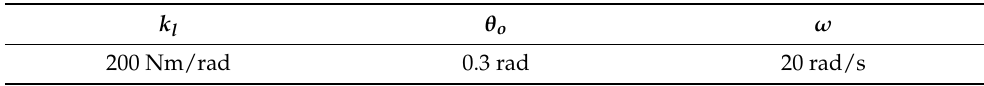
Table 6. Parameters of the elastic load and the loading